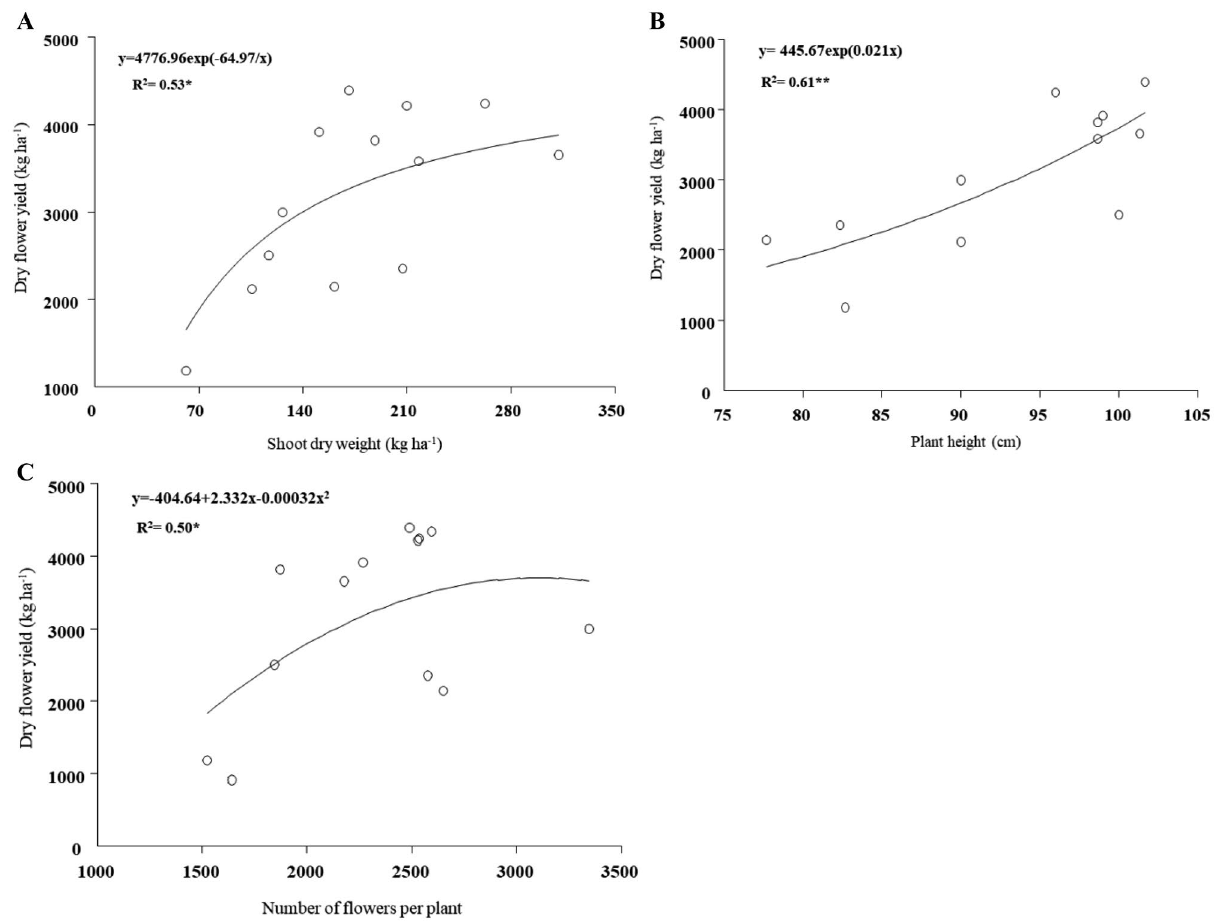
Figure 3. Regression functions of changes of dry flower yield of Echium amoenum against shoot dry weight ( A ), plant height ( B ) and flower number per plant ( C